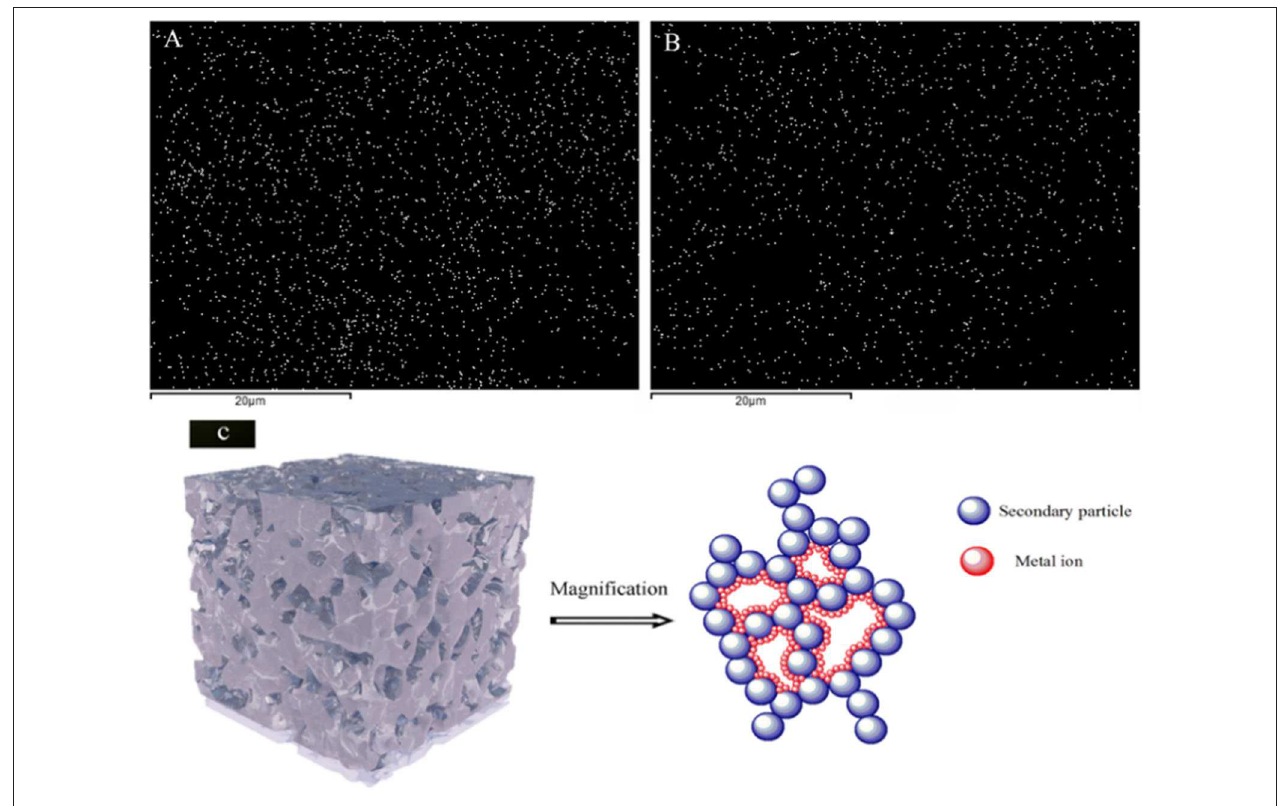
FIGURE 4 | (A) Mg mapping of the Mg 2 + -soaked silica aerogel (S6) after the APD procedure, (B) Mg mapping of S6 after water treatment for 1 day, (C) proposed mechanism for the support from metal ions onto the SA